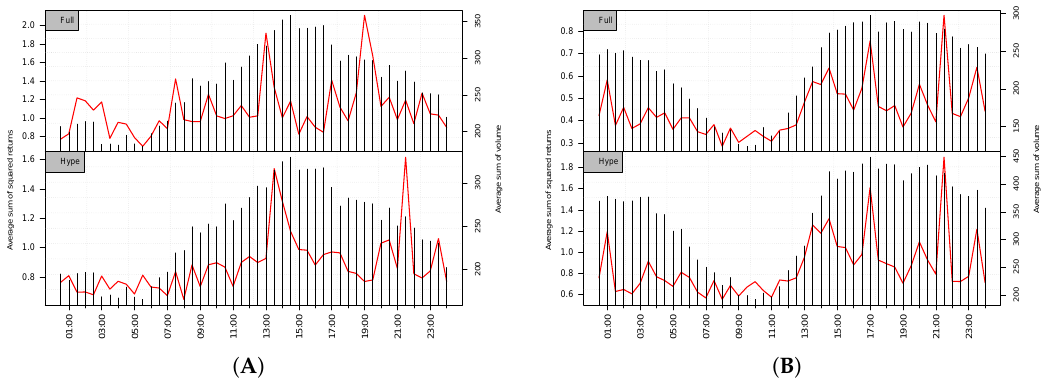
Figure 4. Intraday realized volatility (red lines, left axis) and average volumes (vertical bars, right axis) computed every 30 min for Bitcoin traded at the Bitstamp (panel A ) and Coinbase (panel B ) exchanges.